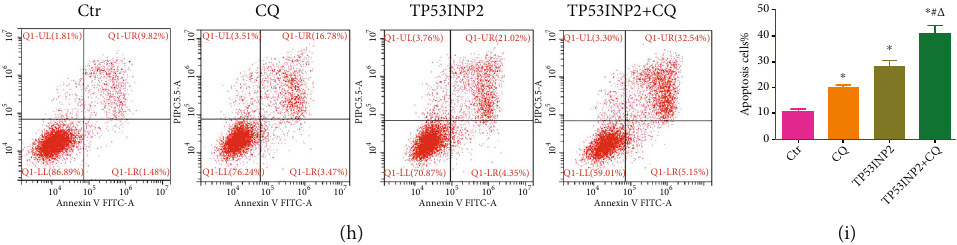
Figure 9: Overexpression of TP53INP2 induces apoptosis in ACHN cells through a nonautophagy dependent pathway. (a) The number of autophagic vacuoles in ACHN cells treated with TP53INP2, mTOR inhibitor Torin1, and TP53INP2+Torin1. (b) and (c) The levels of autophagy-related proteins (TP53INP2, p-mTOR, mTOR, LC3, and p62) were evaluated with western blot. (d) and (e) The expression intensity of LC3 was estimated with immuno fl uorescence. (f) and (g) The levels of proapoptotic protein in ACHN cells treated with TP53INP2, autophagy inhibitor chloroquine (CQ), and TP53INP2+CQ. (h) and (i) Flow cytometry assay was performed for the detection on the apoptosis rate between di ff erent groups. Data are presented as mean ± SD of three or four independent experiments. ∗ P < 0 : 05 , compared to control; # P < 0 : 05 , compared to TP53INP2; △ P < 0 : 05 , compared to Torin1 in (c) and (e), compared to CQ in (i), and P < 0 : 05 , compared to CQ in